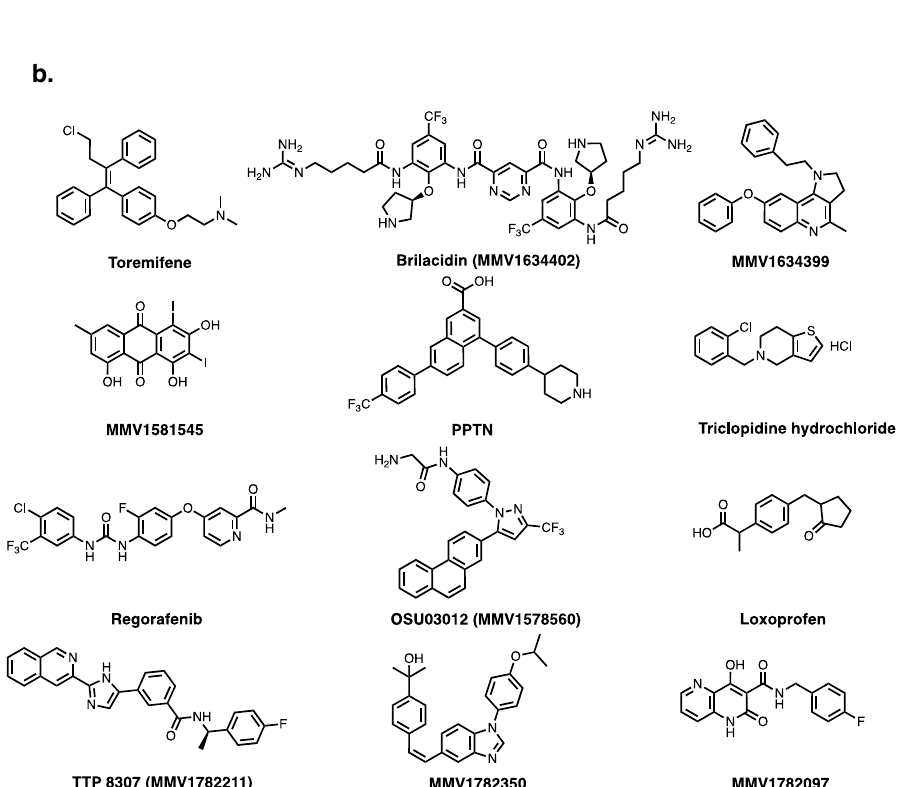
Fig.1|Screeningofrepurposingchemicallibrariesidentifyseveralcompounds that enhance or synergize caspofungin activity. a Heat map of % of metabolic activityusingAlamarblue.The%ofactivityisbasedon A.fumigatus grownfor48hs at37°Cin the absenceor presenceof a speci fi c compound (MM+CAS[0.2 µ g/mL] or MM+enhancers or synergizers alone [20 µ M], or a combination of MM